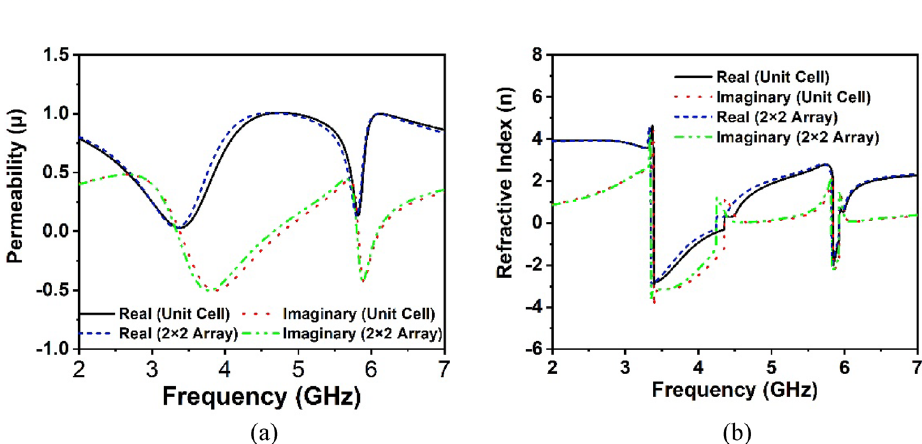
Figure 7. Comparison plots of ( a ) scattering parameters and ( b ) CST extracted permittivity for unit cell and 2 × 2 array.